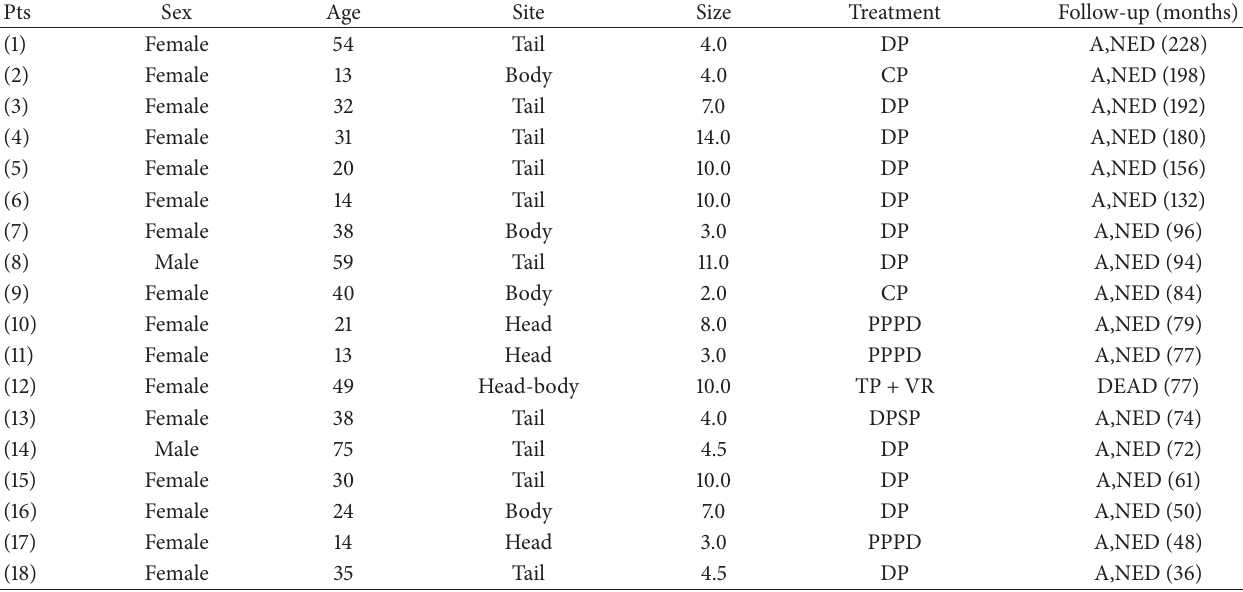
Table 1: Clinicopathologic features of patients with pancreatic SPT.